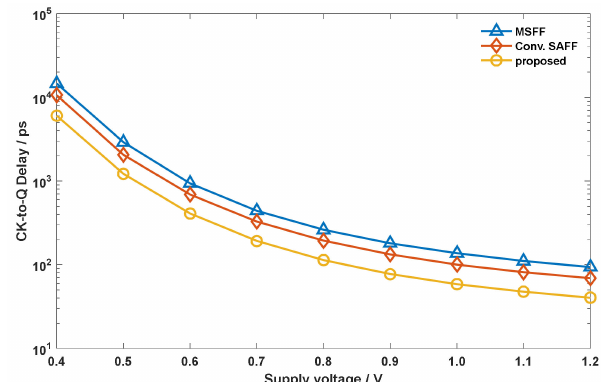
Figure 13. CK-to-Q delay of the proposed flip-flop (FF) as well as that of the MSFF and conventional SAFF at di ff erent supply voltages ranging from 0.4 V to 1.2 V.